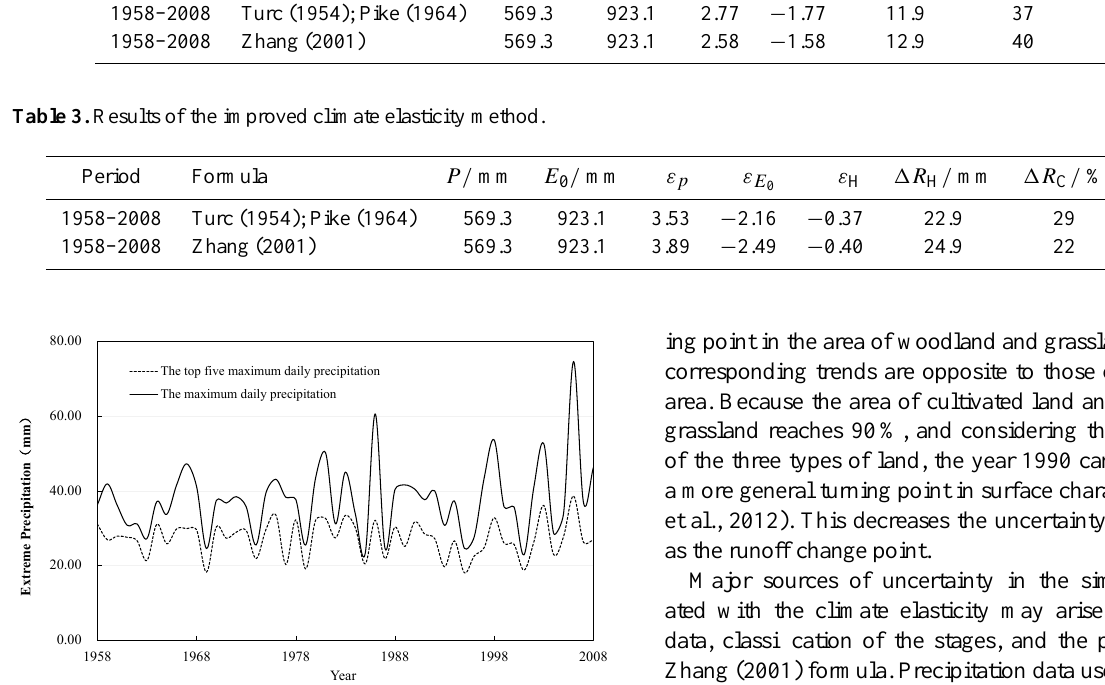
Table 2. Results of the original climate elasticity method. Period